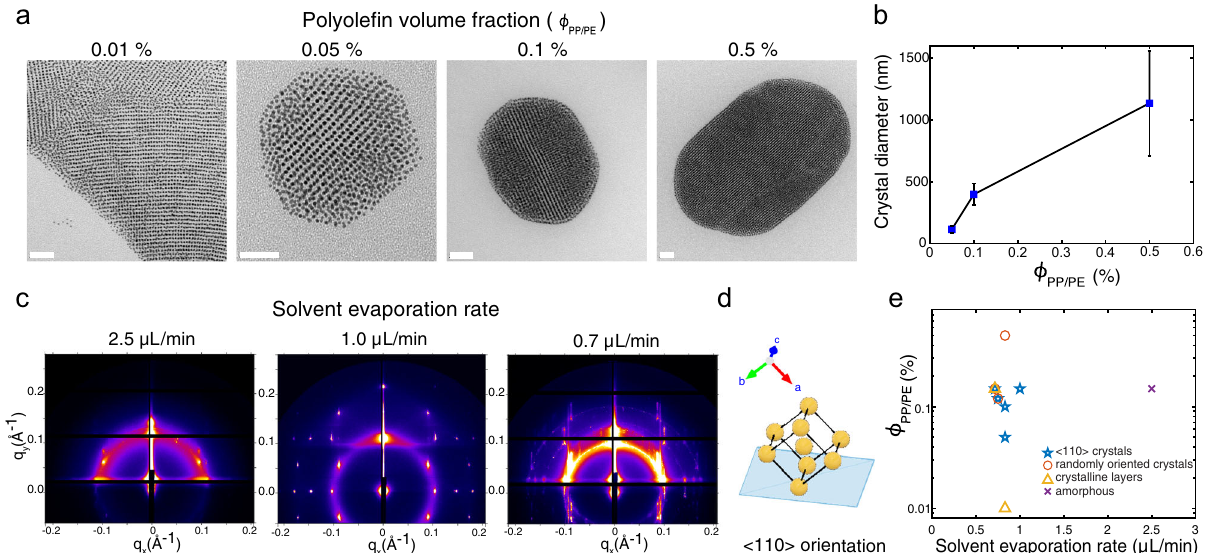
Fig. 2 Effects of polyole fi n loading and solvent evaporation rate on crystal growth. a TEM images of the self-assembled (5.3k) Au-PS 0.60 NPs with different volume fractions of PP/PE. Scale bars are 50 nm for + PP = PE (cid:2) 0 : 01 % , 0 : 05 % , and 0 : 1 % and 200 nm for 0 : 5 % . b Crystal size as a function of polyole fi n loading. Crystals were assembled using (5.3k) Au-PS 0.60 NPs with different volume fractions of PP/PE. Error bars are standard deviations computed from at least 50 crystal measurements. c Two-dimensional GI(T)SAXS patterns of the assembled (1.7k) Au-PS 0.70 NPs with PP/PE at + (cid:2) 0 : 15 % on Si substrates with different solvent evaporation rates. Crystalline layers, substrate-oriented crystals, randomly oriented crystals, and PP = PE amorphous assemblies were all observed. Incident angle α ¼ 0 : 8 (cid:4) for a solvent evaporation rate of 1.0 μ L min − 1 and α ¼ 0 : 14 (cid:4) for other conditions. d A bcc lattice with (110) planes oriented parallel to the substrate. e Phase diagram of the assembled morphologies as a function of solvent evaporation rate and polyole fi n